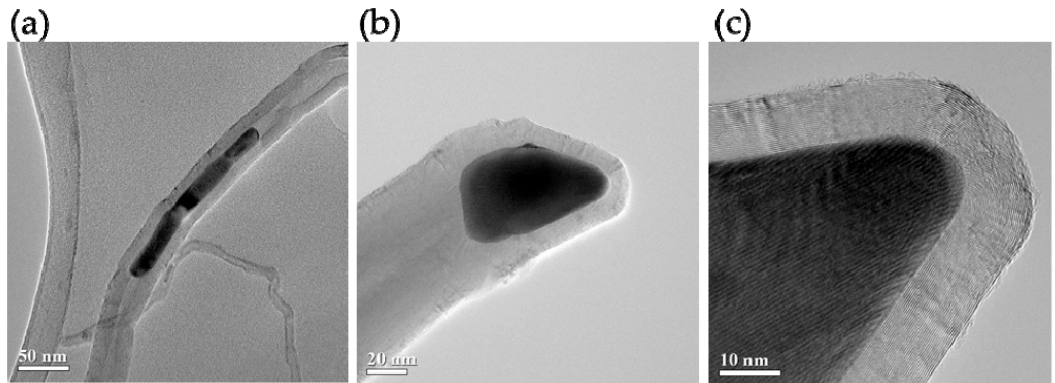
Figure 2. ( a–c ) Transmission electron microscopy images show Fe particles along the length of the carbon nanotube (CNT).